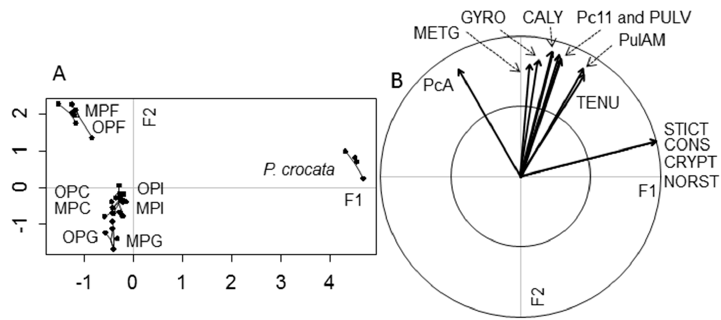
Figure 7. Graphs of the Partial Least Square-Discriminant Analysis (PLS-DA) performed on the specialized metabolites of the lichen Pseudocyphellaria crocata . ( A ) is the score plot obtained on the two first axes (F1, F2) that explain 94.50% of the constrained variances; ( B ) is the corresponding loading plots of specialized metabolites. The cross-model validation used for the discrimination of the lichen parts (8 components, 999 permutations, NMC = 0.668; p = 0.004) indicated statistically different biochemical profiles. The samples are crop (C), intestine (I), digestive gland (G), and feces (F) of organic (OP) and mineral (MP) phenotypes. The metabolites are constictic (CONS), cryptostictic (CRYPT), stictic (STICT), norstictic (NORST), pulvinic (PULV), gyrophoric (GYRO), and 4- O -methylgyrophoric (METG) acids, calycin (CALY), and pulvinamide (PulAM), Pc11 detected in the lichen but unidentified, and the unidentified PcA that only arose in the snail gut.